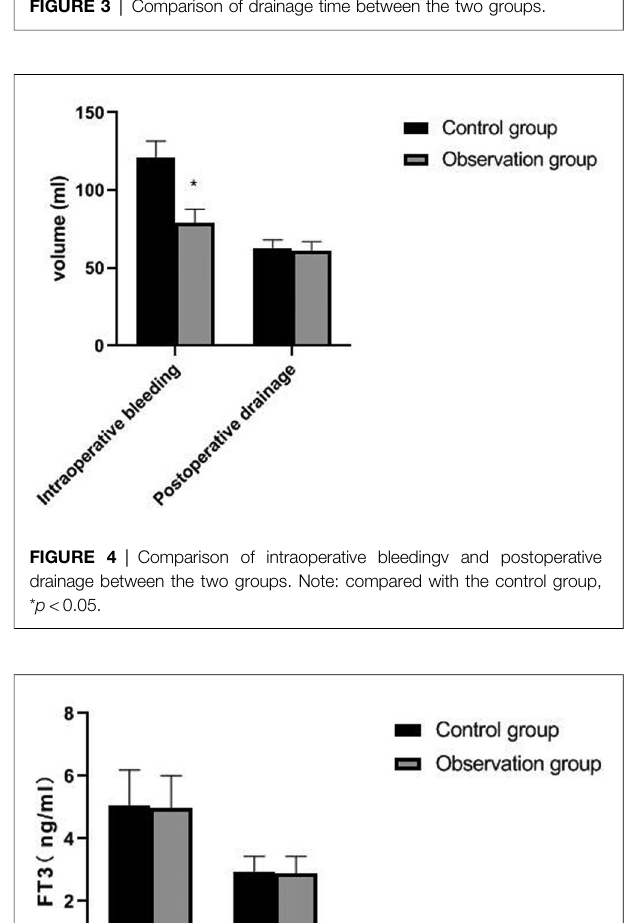
FIGURE 8 | Comparison of PTH levels between the two groups. Note: compared with the control group, * p <0.05.